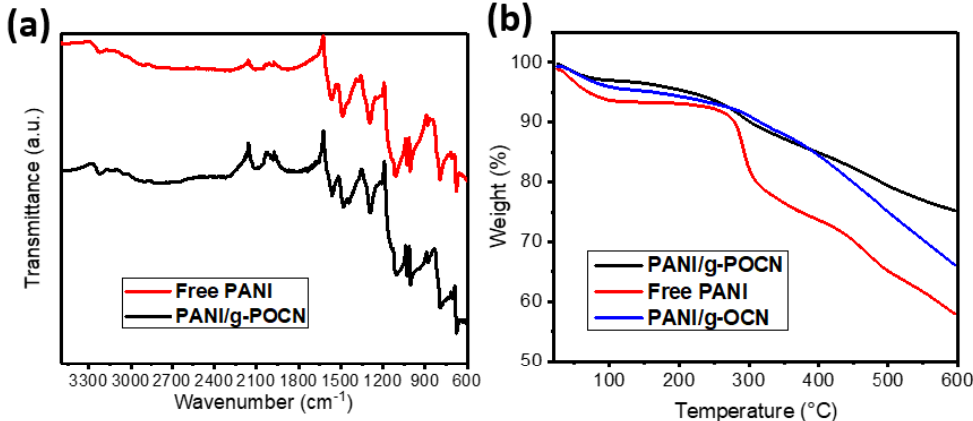
and PANI/g-POCN Figure 3. ( a ) Free PANI and PANI/g-POCN composites FTIR spectra. ( b ) Free PANI, PANI/g-OCN and PANI/g-POCN thermograms.